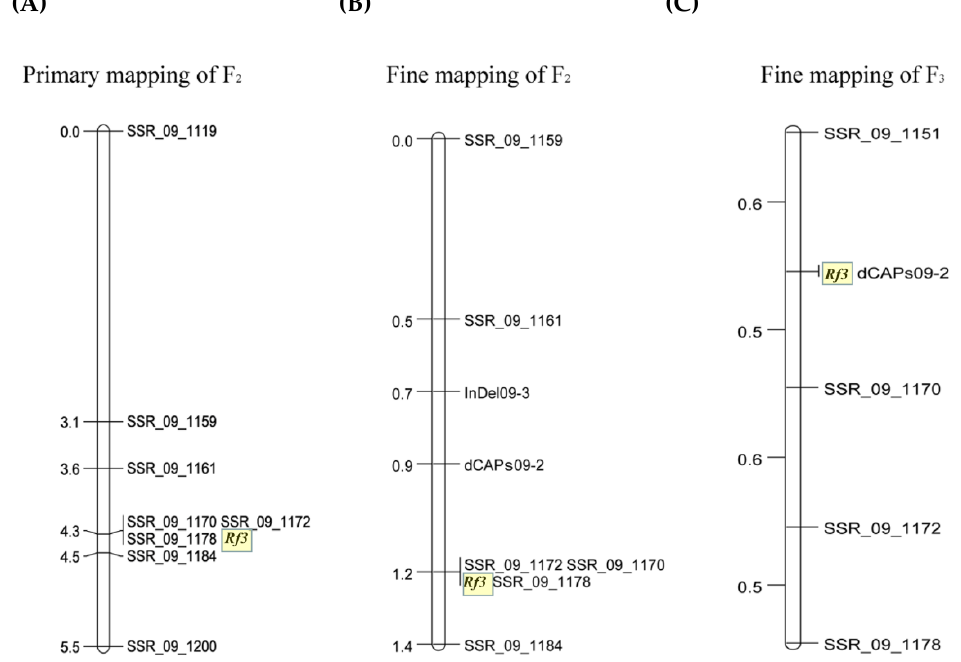
Figure 3. ( A – C ) Genetic mapping of the Rf3 locus on chromosome 9.